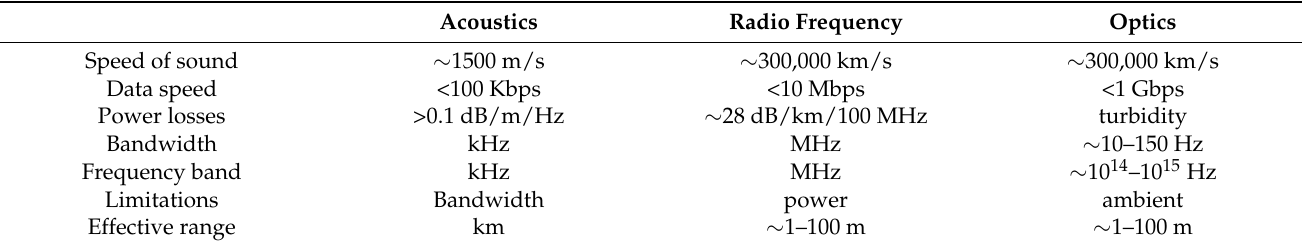
Table 1. Comparison of underwater communication